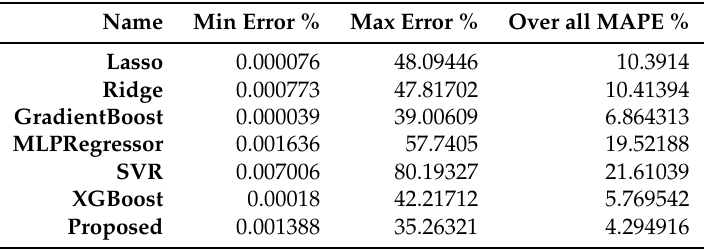
Table 3. Comparison of mean absolute percent error.